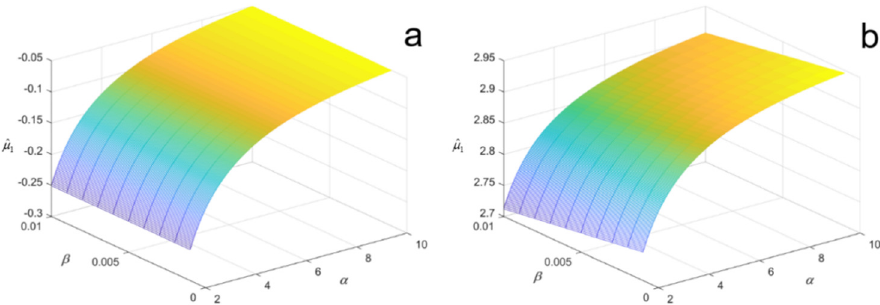
Figure 4. Three-dimensional plots of ˆ µ I versus α and β based on Method I. ( a ) Scenery of µ WJ = 0; ( b ) Scenery of µ WJ = 3 .